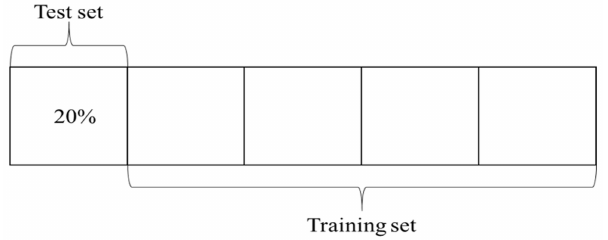
Figure 11. Five-fold